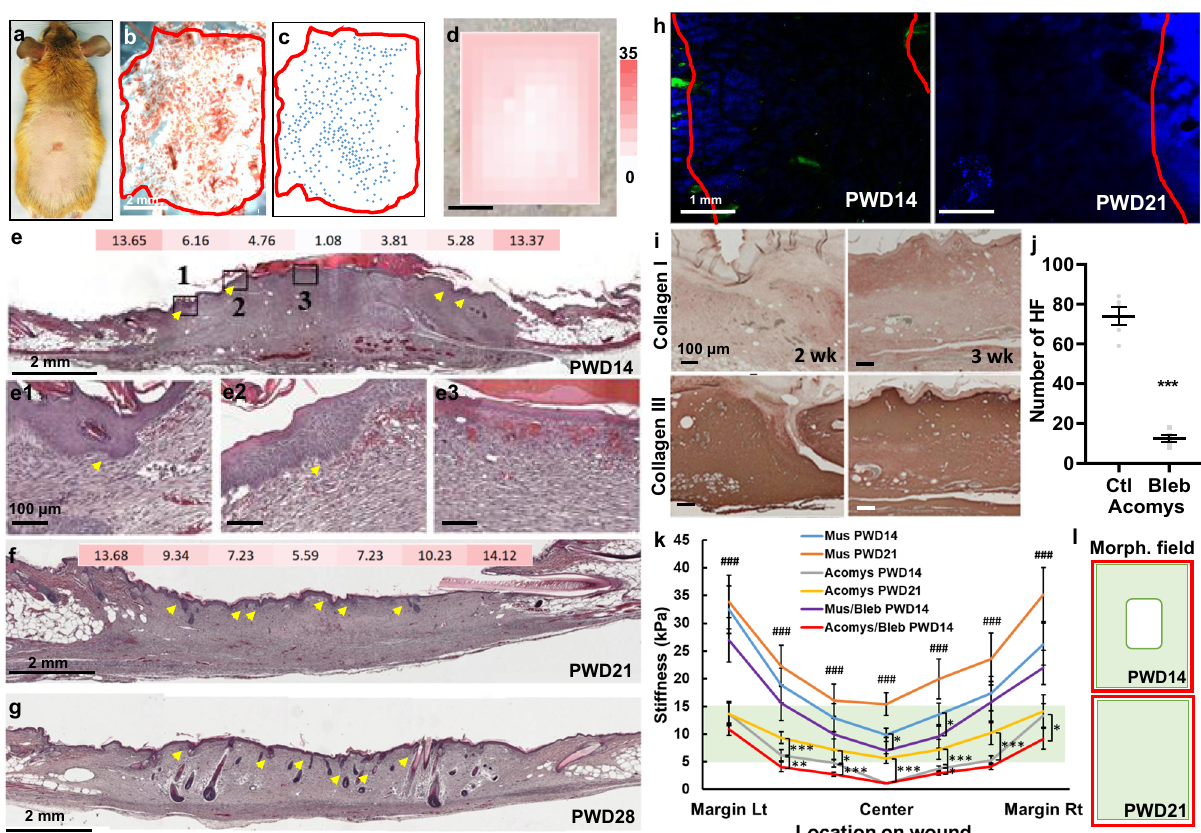
Fig. 2 African spiny mice exhibit an optimal range of tissue stiffness for placode formation. a A spiny mouse on PWD28. b K15 wholemount immunostaining of a PWD28 spiny mouse wound. Red line: border of the wound bed. c Schematic diagram of hair follicles (blue dot) in b . d The stiffness heatmap overlaying the PWD14 spiny mouse wound. Colorimetric unit: kPa. e H&E histology and stiffness heatmap of PWD14 and f PWD21 wounds. The color and number indicate the stiffness of the wound at respective location. Unit: kPa. ( e1 – e3 ) enlarged images of regions 1, 2, and 3 from e . g H&E of the PWD28 wound. Yellow arrows indicate the formation of hair placode. h SHG of PWD14 and PWD21 spiny mouse wounds. Red line: wound border. i , IHC of collagen I and collagen III in spiny mouse at different post-wound time. j Blebbistatin treatment signi fi cantly reduced the resultant number of hair neogenesis. n = 5 biologically independent animals. Data are presented as mean values ± SEM. p < 0.0001, unpaired two-sided t -test. k Graph indicating the respective wound stiffness of the speci fi c wound location and time in the laboratory and spiny mice. n = 10 regions examined over 5 biologically independent animals per location per condition. Data are presented as mean values ± SD. ### p < 0.0001 when compared between Mus PWD14 and Acomys PWD14; * p = 0.0482 when compared between Mus PWD14 and Mus/Bleb PWD14 center, p = 0.0218 when compared between Mus PWD14 and Mus/Bleb PWD14 at the right of wound center, p = 0.0441 between Acomys PWD14 and Acomys PWD21 at the left of wound center, p = 0.0381 when compared between Acomys PWD14 and Acomys/Bleb PWD14 wound margin right, p = 0.0421 at center-right, ** p = 0.0089; *** p < 0.0001. One-way ANOVA, Tukey test. l Illustration of morphogenetic fi eld in PWD14 and PWD21 spiny mouse wound bed. Red: wound border. Green: morphogenetic fi eld. ### : p < 0.005. Ctl: control; Bleb: Blebbistatin; Lt: left; Rt: right; Morph: morphogenetic. The images in a – g , i represent fi ve out of fi ve experiments performed. The images in h represent 4 out of 4 experiments